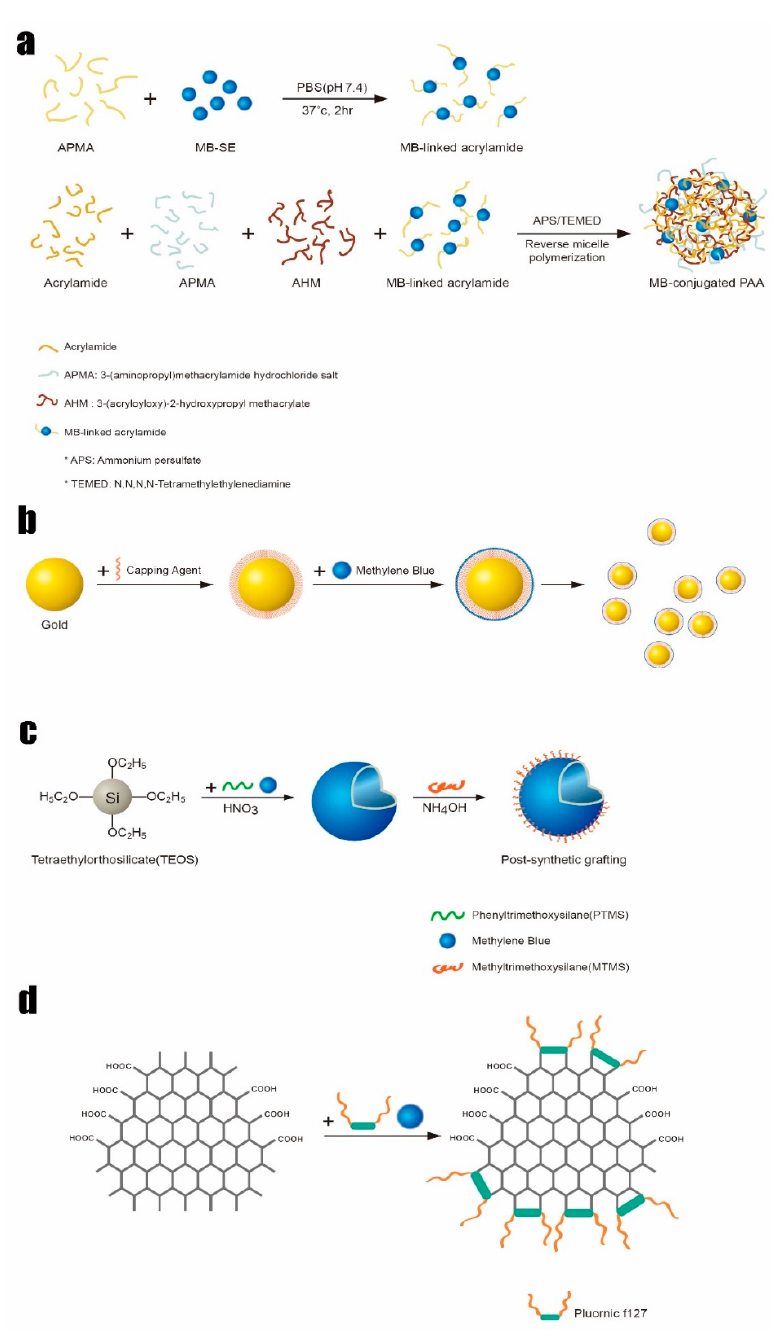
Figure 3. Fabrication techniques for methylene blue (MB) encapsulation. ( a ) MB-embedded polyacrylamide nanoparticles, ( b ) Gold nanoparticles electrostatically tethered with MB, ( c ) MB-embedded hollow silica nanoparticles, ( d ) Nano graphene oxide covalently tethered with MB.